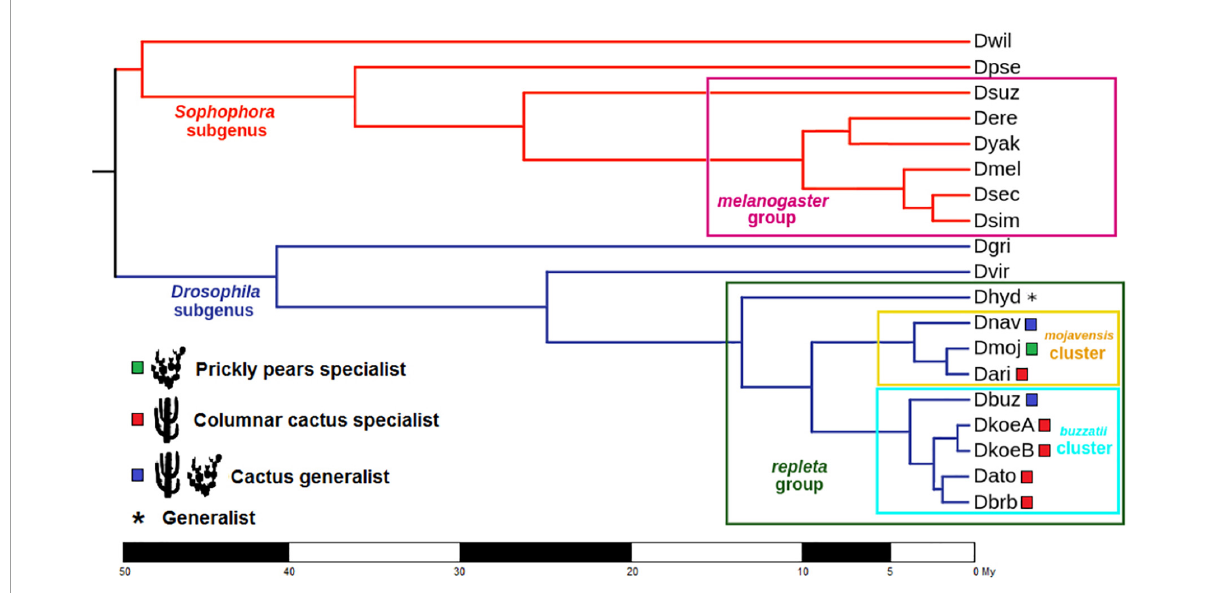
FIGURE1 Phylogenetic tree of the Drosophila species included in this study. The host use is indicated for specialists in prickly pear-type Opuntia spp. (green square) and columnar cacti (red square), cactus generalists (blue square), and generalists (asterisk) in each species of the repleta group. D. buzzatii is denoted as a cactus generalist, although a high preference for prickly pear-type hosts has been reported. Divergence times for species of the repleta group were obtained from Moreyra et al. (2022) and for the other species from the Timetree database (Kumar et al.,